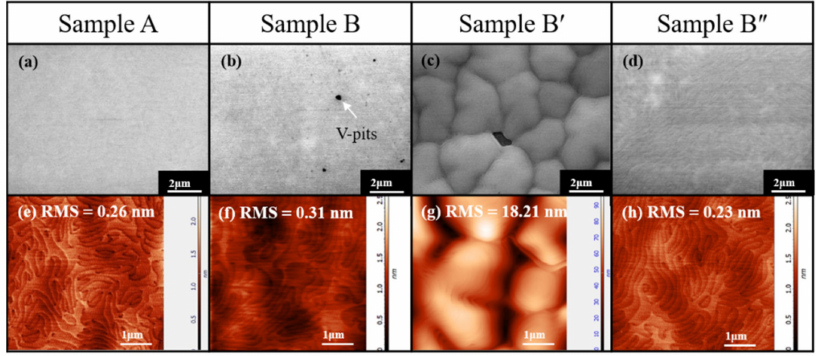
Figure 3. ( a – d ) SEM and ( e – h ) AFM images of the four Samples A, B, B (cid:48) , and B (cid:48)(cid:48) .